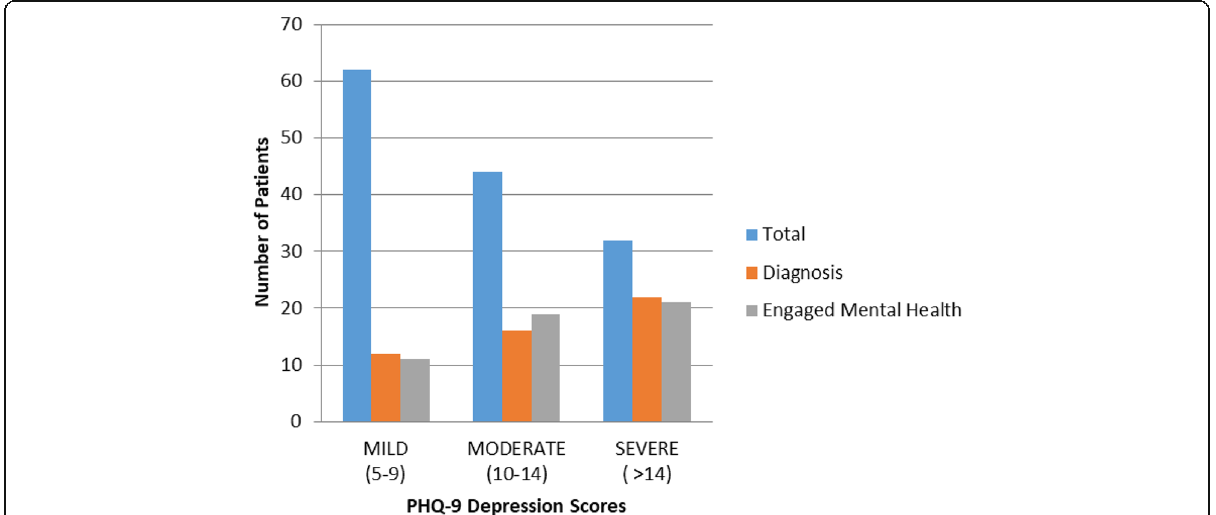
Fig. 1 Practice gap in patients screening positively for depression. Patients who screened positively on PHQ-9 for depression were evaluated for a formal diagnosis made by a medical provider and for engagement of mental health services